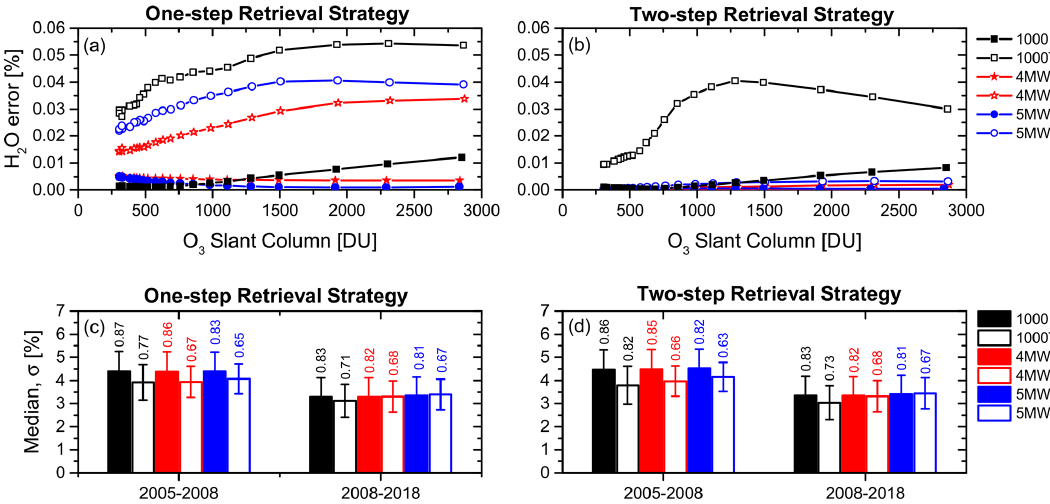
Figure A1. Summary of the impact of the treatment of H 2 O on O 3 retrievals for all O 3 setups. (a, b) H 2 O cross-interference error in the O 3 total column (%) using the one-step and two-step retrieval strategies, respectively, as a function of O 3 slant column (DU) for the measurements of Fig. 3. (c, d) Statistics for the FTIR–Brewer relative differences using the one-step and two-step retrieval strategies, respectively, for the periods 2005–May 2008 and June 2008–2018. Median ( M , in %) and standard deviation ( σ , presented as error bars and numerals in %) values are